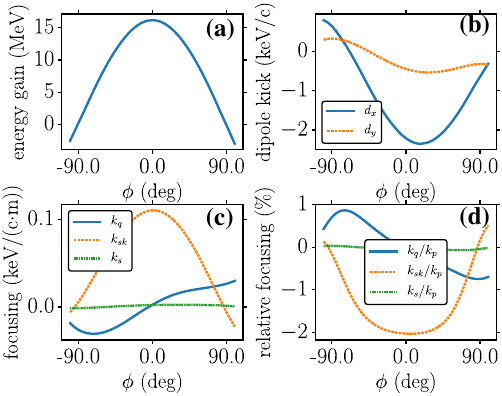
FIG. 3. Energy gain (a), dipole kicks (b), absolute (c), and relative (d) focusing strengths as function of phase ( ϕ ¼ 0 corresponds to on-crest acceleration). The relative focusing strength is normalized to the ponderomotive focusing strength k p in Eq. (5). The simulation conditions are an injection energy of 10 MeV and E 0 ¼ 30 MV =